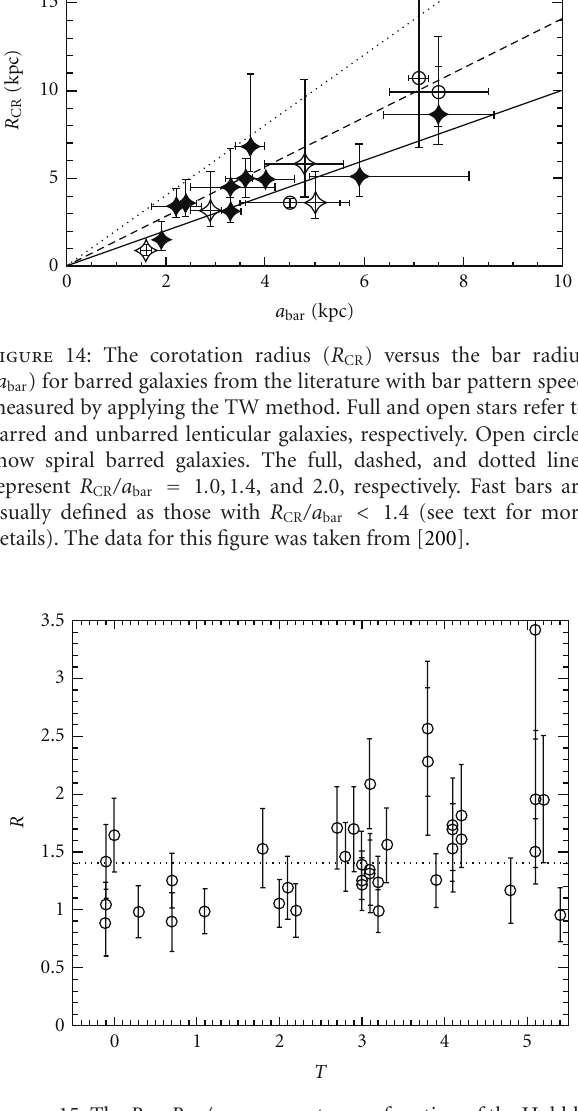
Figure 15: The R = R CR /a bar parameter as a function of the Hubble type. The horizontal line ( R = 1 . 4) represents the separation between fast and slow bars. Credit: Rautiainen et al. [208]. Repro- duced by permision from